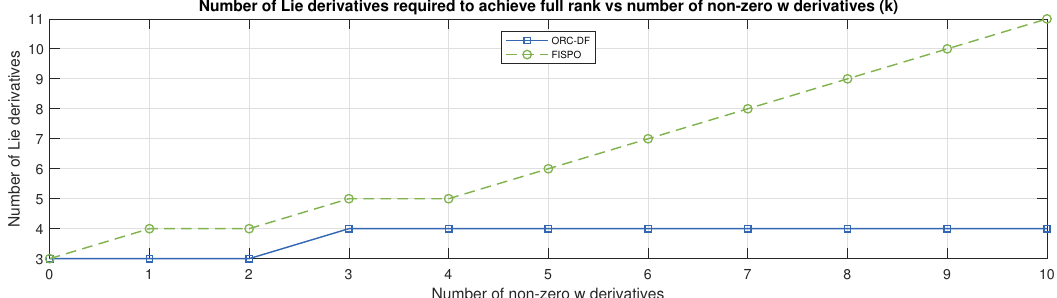
Figure 4. Number of Lie derivatives needed by each algorithm for building the full-rank observability matrix for the 2DOF model as a function of s , the number of non-zero w ( t ) time derivatives, for 0 ≤ s ≤